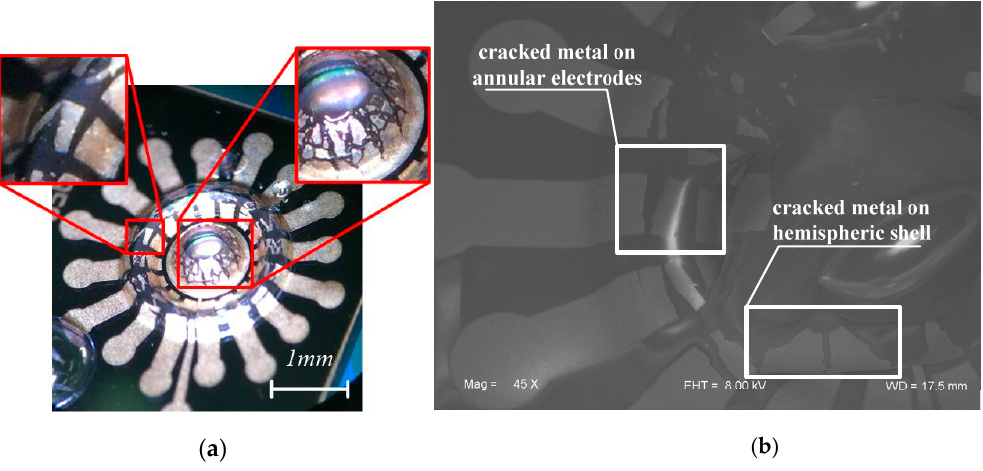
Figure 7. Photographs of initially fabricated annular electrodes and hemispheric shell. Not only the metal on center shell is cracked, but also the annular electrode. ( a ) is observed by optical microscope; and ( b ) is by Scanning Electron Microscope (SEM).